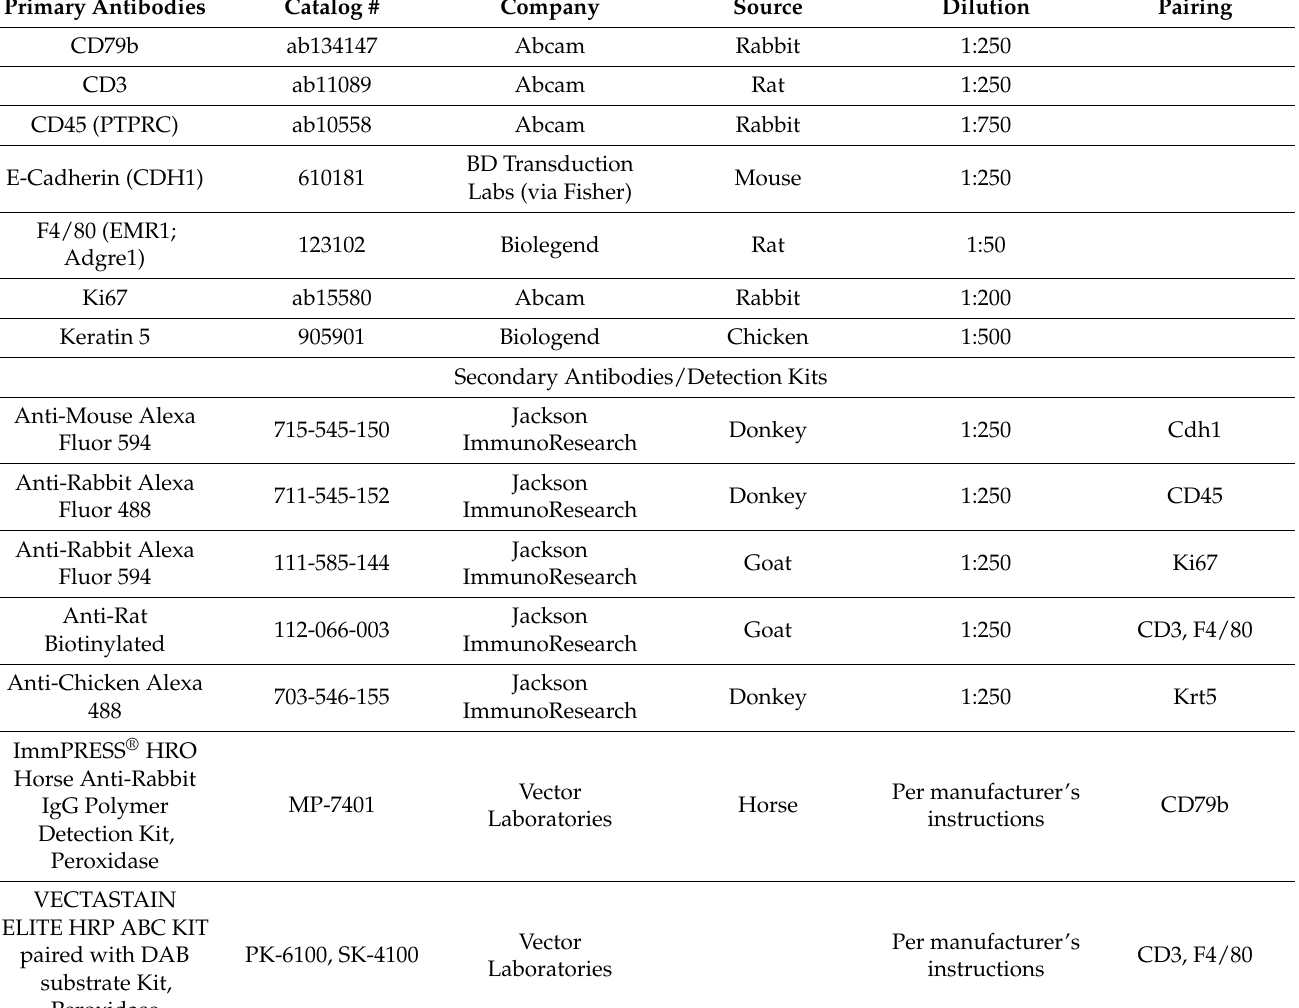
Table 1. List of